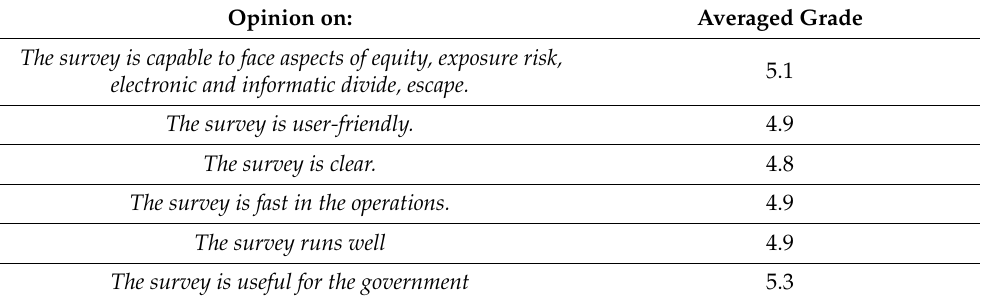
Table 1. Opinions of the 103 insiders on the survey (1 = minimum grade; 6 = maximum grade). Opinion on: Averaged